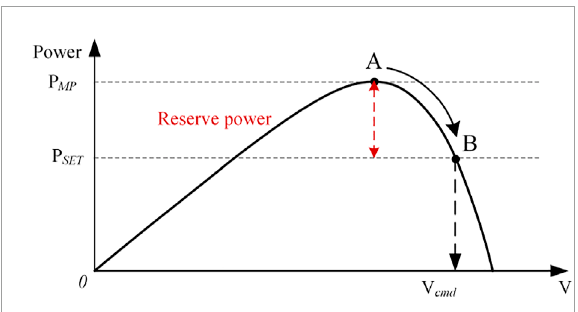
FIGURE 4 Movement of PV power reserves by the operating point away from the MPP.